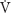
(A) Representative (n = 1) NIRS mO2 recovery curve from pre (white circle) and post (black circle) following a 7-day IPC intervention. Data is fitted to a non-linear monoexponential curve and a rate constant (k) derived. (B) Bar graph illustrates average rate constants for pre (black) and post (white) for the IPC (n = 10) and sham (n = 10) groups. ∗P > 0.05.